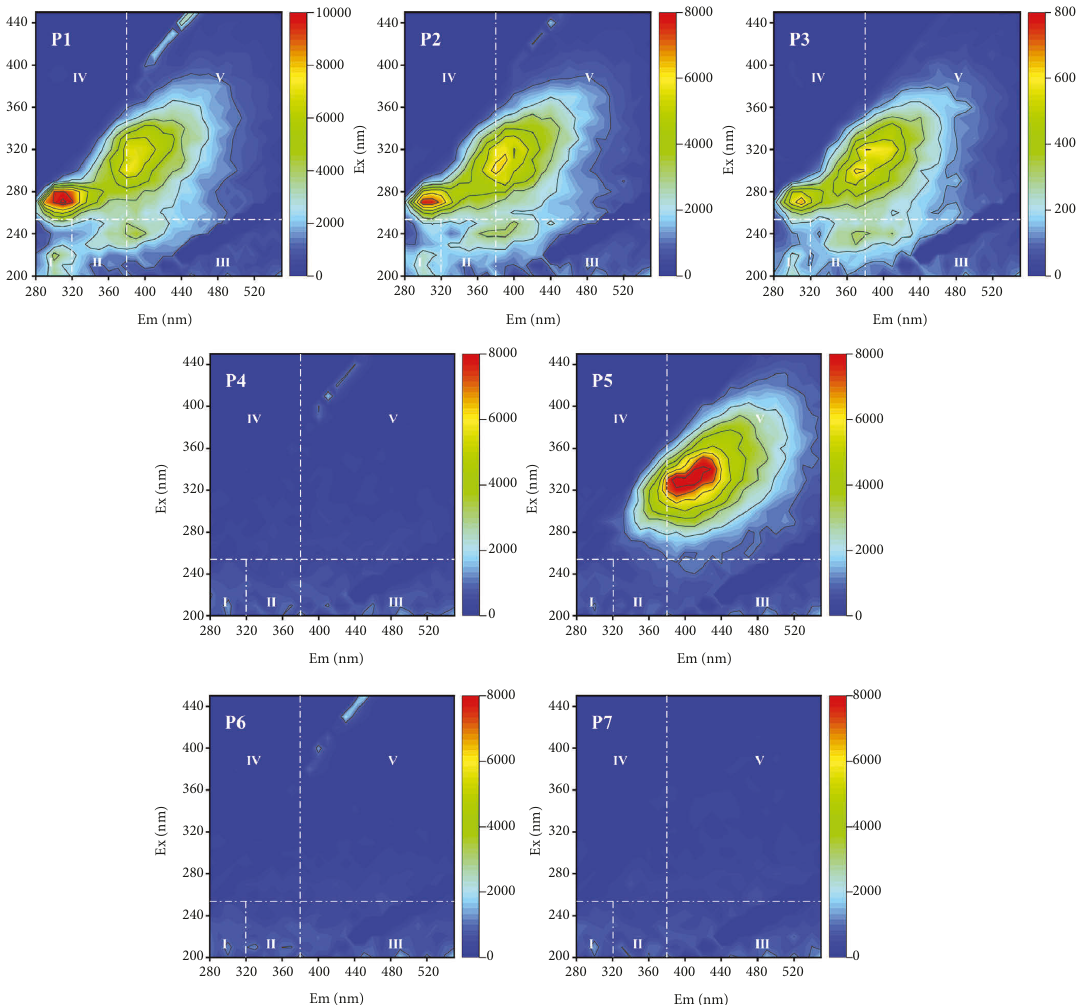
Figure 6: Typical EEM matrix of effluent from different processes (P1: raw wastewater, P2: DF, P3: AS, P4: FO, P5: no dilution FO, P6: RO, and P7: no dilution